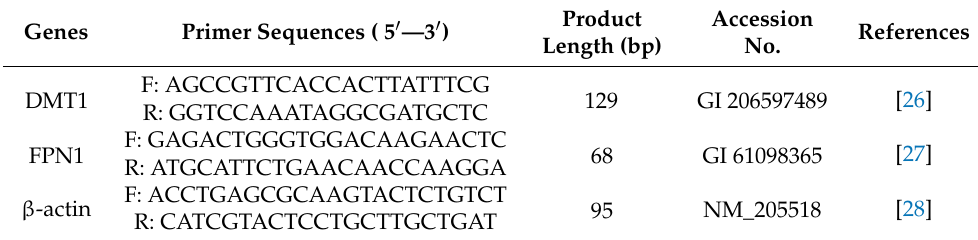
Table 4. Primer sequences for real-time fluorescent quantitative PCR 1 .